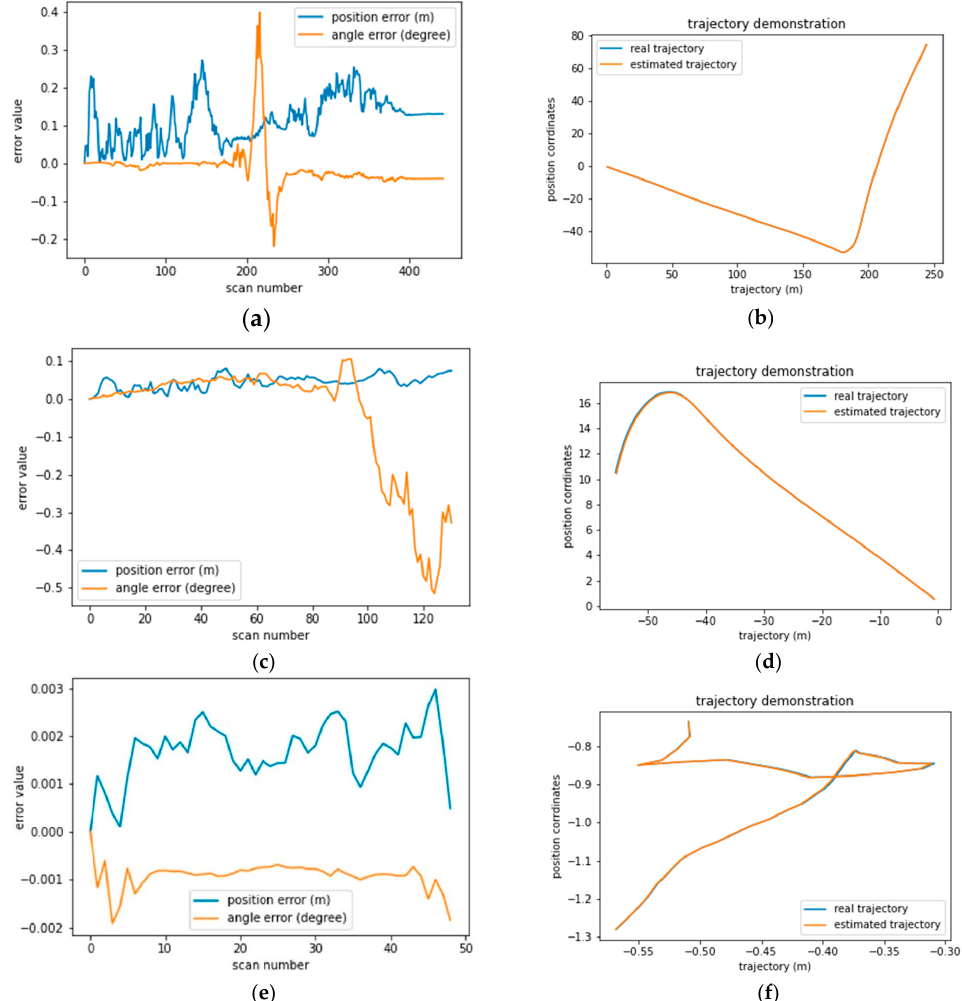
Figure 7. Graphical display of the average absolute position and angular error relative to the vehicle